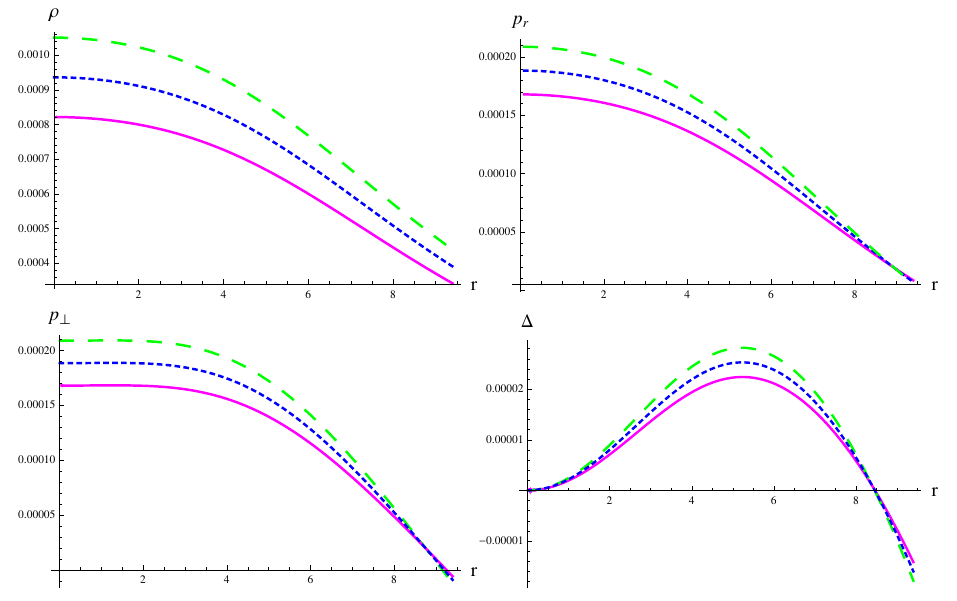
Figure 12. Behavior of ρ , p r , p ⊥ (in km − 2 ) and ∆ of anisotropic solution II for Υ = 0.9.